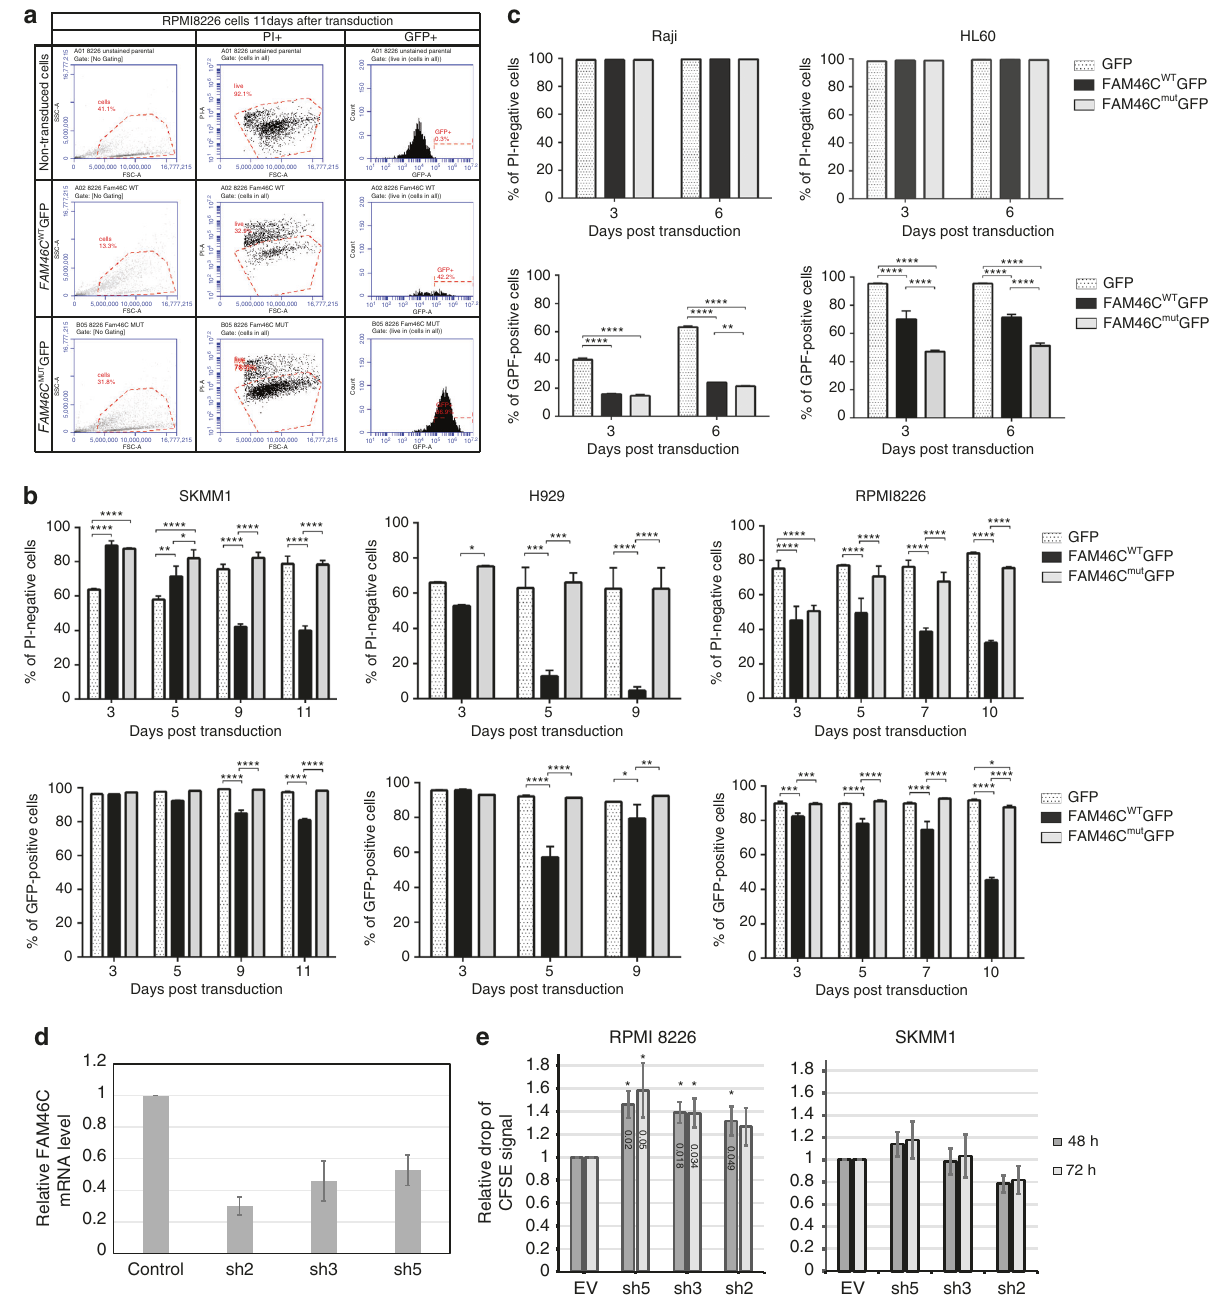
Fig. 4 FAM46C control survival and proliferation of multiple myeloma cells. a – c Expression of FAM46C WT induces death in multiple myeloma cells. a An example gating strategy for de fi ning transduction ef fi ciency and cell viability. Forward scatter (FSC) and side scatter (SSC) gate were used to separate debris from intact cells. Viability of RPMI8226 cells overexpressing either FAM46C WT -GFP or FAM46C mut -GFP was analyzed using propidium iodide (PI) staining on the 11th day post-transduction. GFP expression (GFP+) was evaluated in parallel in PI-negative cells. b , c Summary of fl ow cytometry analyses presented as bar graphs showing GFP expression level and reduced viability of multiple myeloma cell lines (SKMM1, H929, and RPMI8226 in b and Raji and HL60 in c throughout the time course of GFP, FAM46C WT -GFP, and FAM46C mut -GFP expression. The data are presented as percentage of cells ± SD ( n = 3). P values were calculated using two-way ANOVA tests (* P < 0.05, ** P < 0.01, *** P < 0.001, **** P < 0.0001). d , e shRNA-mediated silencing of FAM46C enhances proliferation rate of RPMI8226 MM cell line expressing wild-type protein but not SKMM1 harboring FAM46C mutation. Cells were transduced with lentiviral vectors expressing shRNA and empty vector as control. Stable transduced cell lines were stained with CFSE. Cell division was monitored by fl ow cytometry after 48 and 72 h by levels of CFSE dilution. d Reverse transcription qPCR analysis of the FAM46C silencing ef fi ciency. Bars represent mean values ± SD ( n = 3). e The rate of proliferation of shRNA treated cells normalized to the control transduction. Bars represent mean values ± SD. P -values were calculated using Student ’ s t -test (* P < 0.05), ( n =